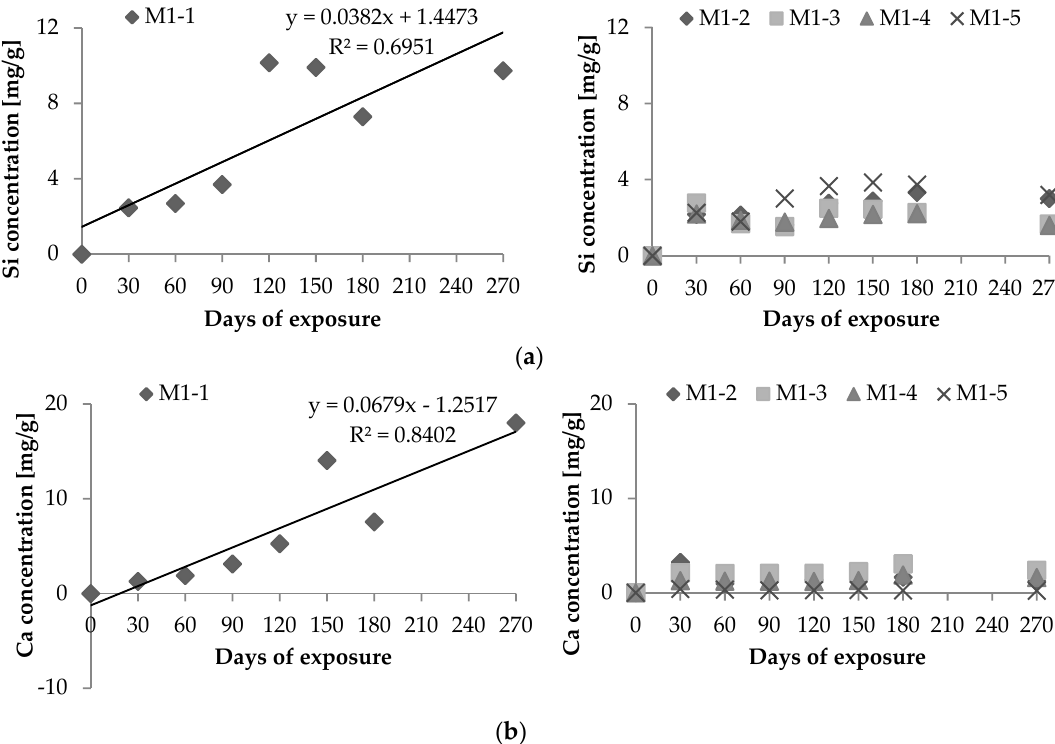
Figure 2. Dissolved: ( a ) Si 4+ and ( b ) Ca 2+ corresponding to 1 g of concrete samples with the addition of silica fume.